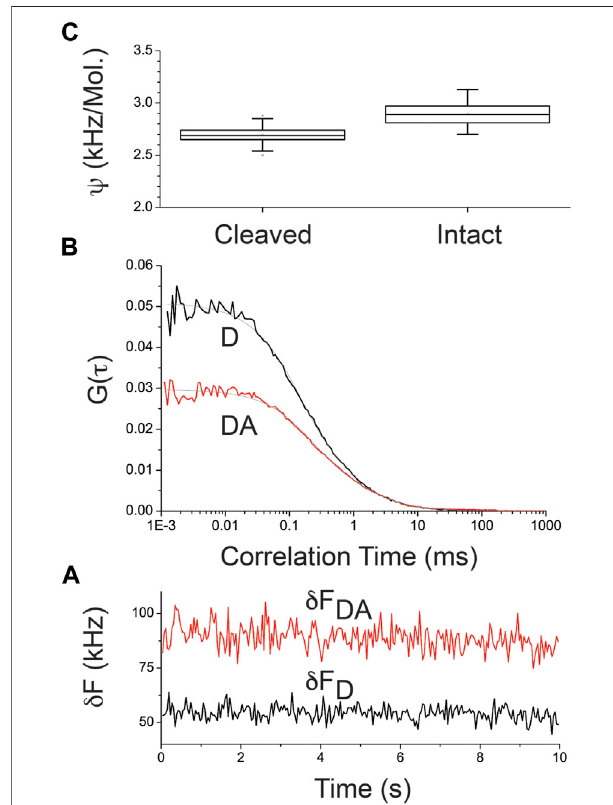
FIGURE 4 | Representative autocorrelation curves and molecular brightness of cleaved and intact crTC2.1 construct under 488-nm excitation (A) Representative fl uorescence fl uctuation traces of cleaved (D, black curve) and intact (DA, red curve) crTC2.1, which were measured under the same experimental conditions (B) The corresponding autocorrelation curves of cleaved (D, black curve) and intact (DA, red curve) crTC2.1 under 488 nm excitation and 531/50 nm detection using these representative fl uorescence fl uctuations (A) (C) Representative box and whisker plots of the molecular brightness ( ψ , kHz/molecule) of intact and enzymatically cleaved crTC2.1 in 10 mMNaPibuffer arealsoshown ( n (cid:2) 20).Under488 nmexcitation (2 μ W or 1.6 kW/cm 2 ) observation volume, the fi tting parameters of these representative autocorrelation curves (B) are as following: the translational diffusion times are 0.47 ms (cleaved) and 0.83 ms (intact) with a fast photophysical process with time scales of 150 μ s (cleaved, 44%) and 233 μ s (intact, 44%). The corresponding number of molecules residing in the observation volume here are 20 (cleaved) and 34